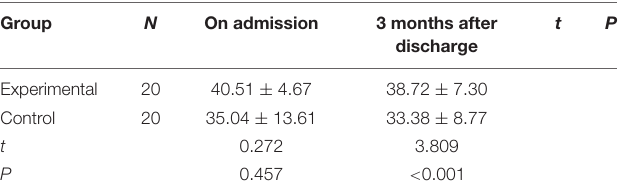
TABLE 5 | Comparison of life compliance scores between the two groups of IBD patients at admission and 3 months after discharge (x ± s). Group N On admission 3 months after